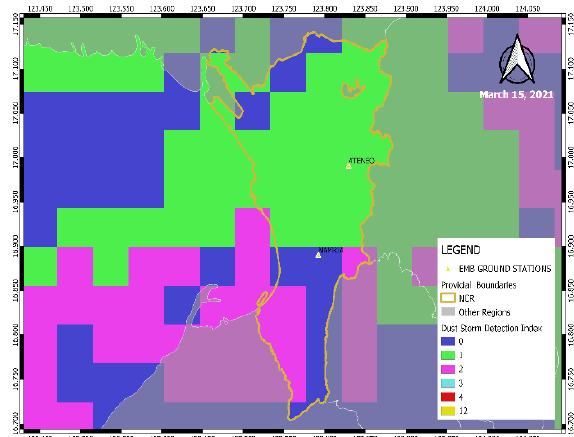
Figure 11. FY-4A DSD product acquired on March 15,